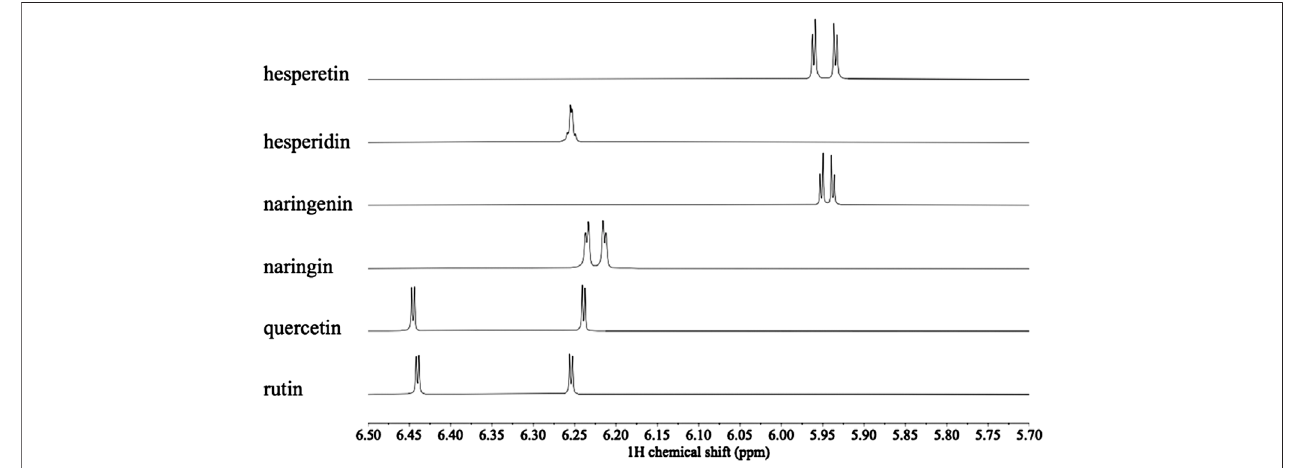
FIGURE 2 | Comparison of 1 H NMR spectra of hesperetin, hesperidin, naringenin, naringin, quercetin and rutin (600 MHz in CH 3 OH- d 4 ) in the range δ 5.7 – 6.5 for H-6 and H-8.